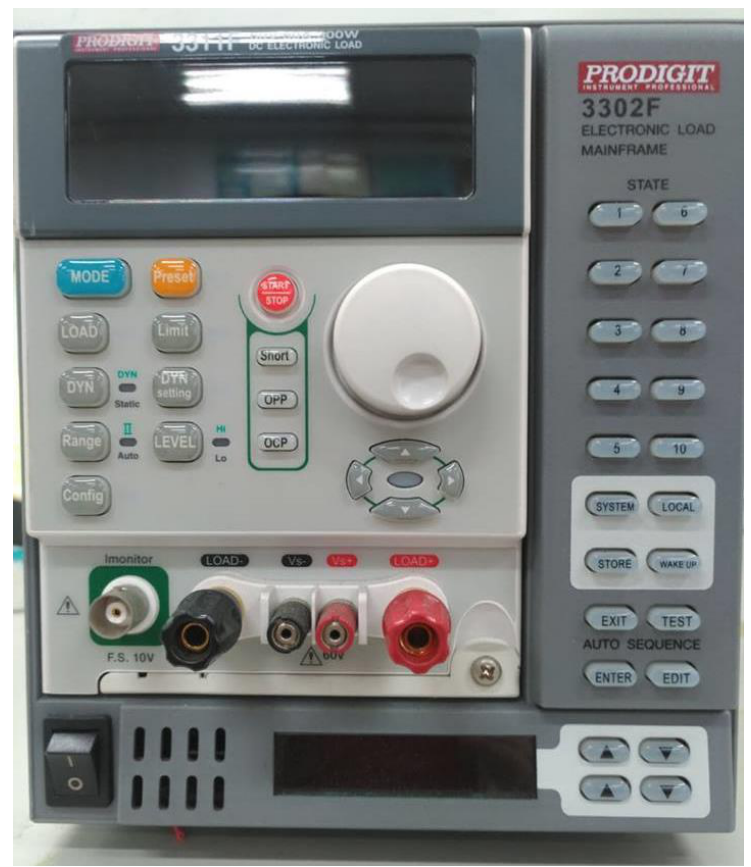
Figure 8. 3311F DC Load.